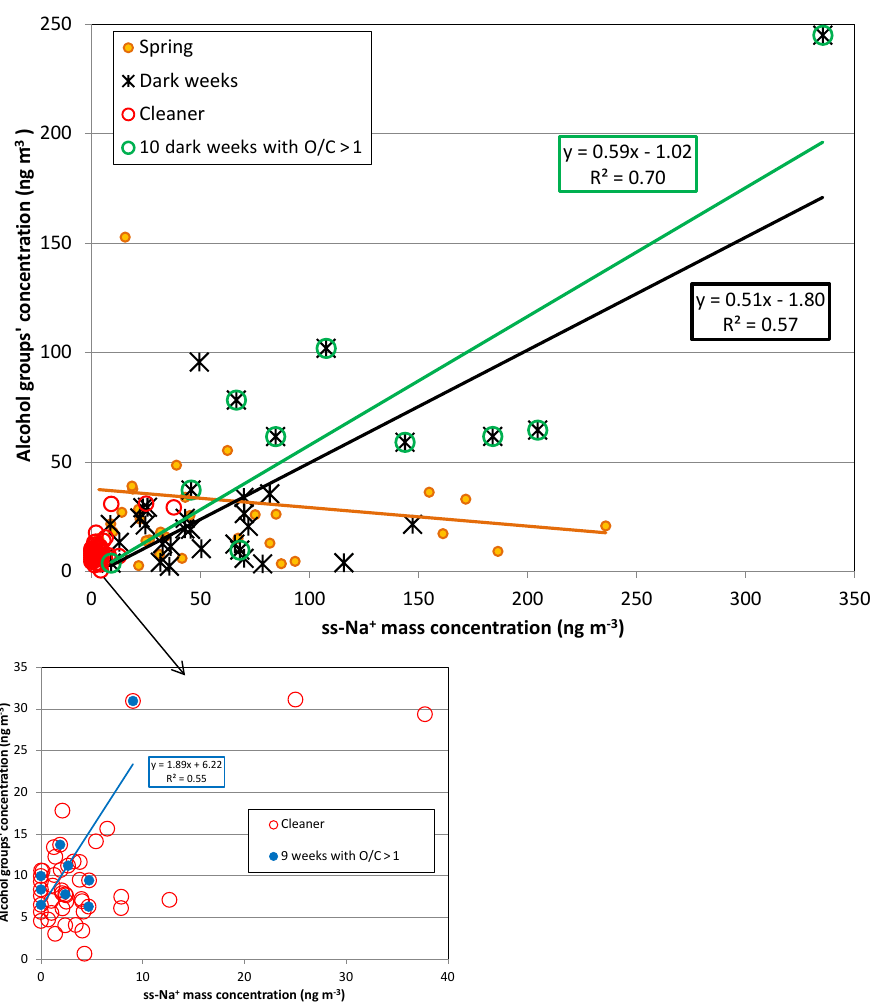
Figure 10. Regressions of weekly-averaged mass concentrations of alcohol functional groups with ss-Na + for the spring weeks, dark weeks, cleaner weeks and the 10 dark weeks with O / C>1. Results of linear regressions are indicated where significant ( p <0.05). The lower plot expands the cleaner weeks and identifies the 9 weeks during July and August of 2013 with O /